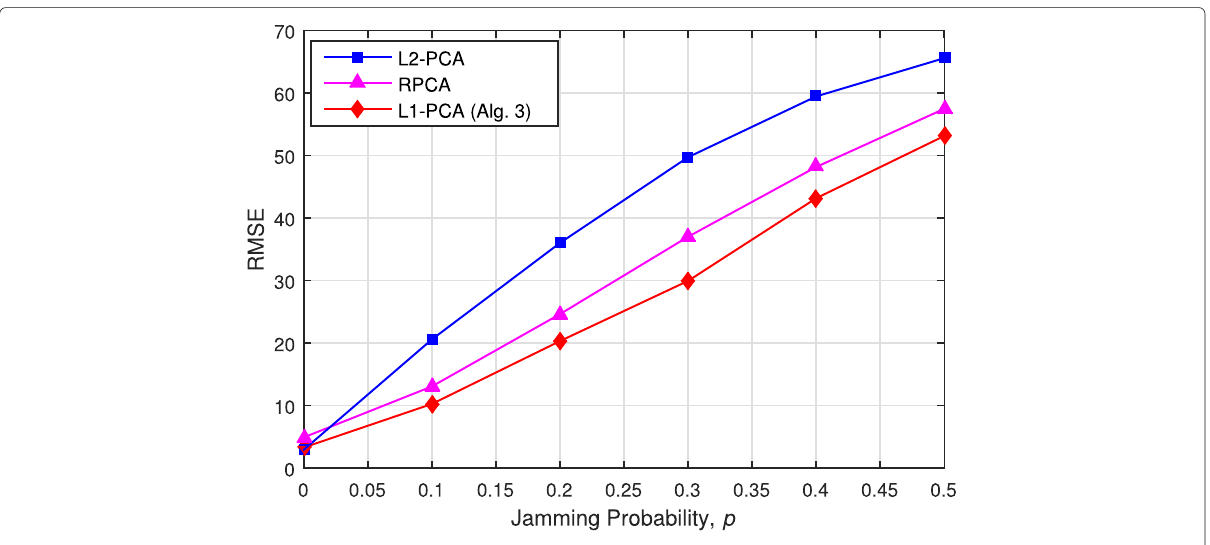
Fig. 9 RMSE vs. jammer operation probability p , for: L2-PCA (MUSIC), RPCA [29], and L1-PCA by means of Algorithm 3 in Fig. 4. N = 10, D = 4, θ = − 20 ◦ , θ (cid:13) = 50 ◦ , source SNR 5dB, jammer SNR 10